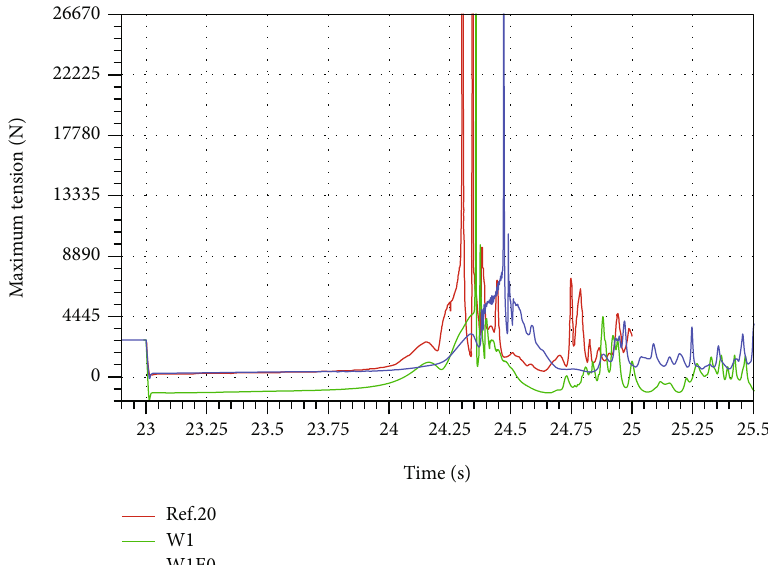
Figure 5: Case W1 tension time history in comparison with Ref. 20.